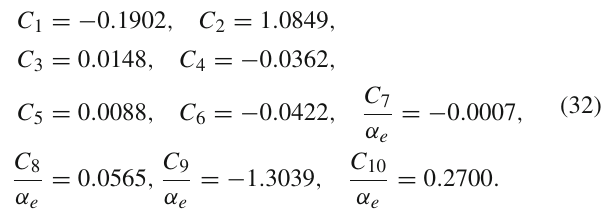
Table 2 The form factors F B c